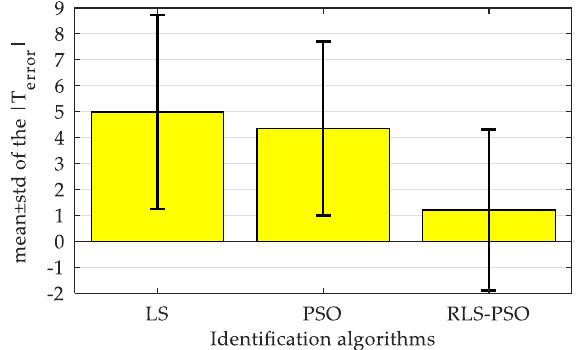
Figure 13. The mean ± std of the absolute errors.